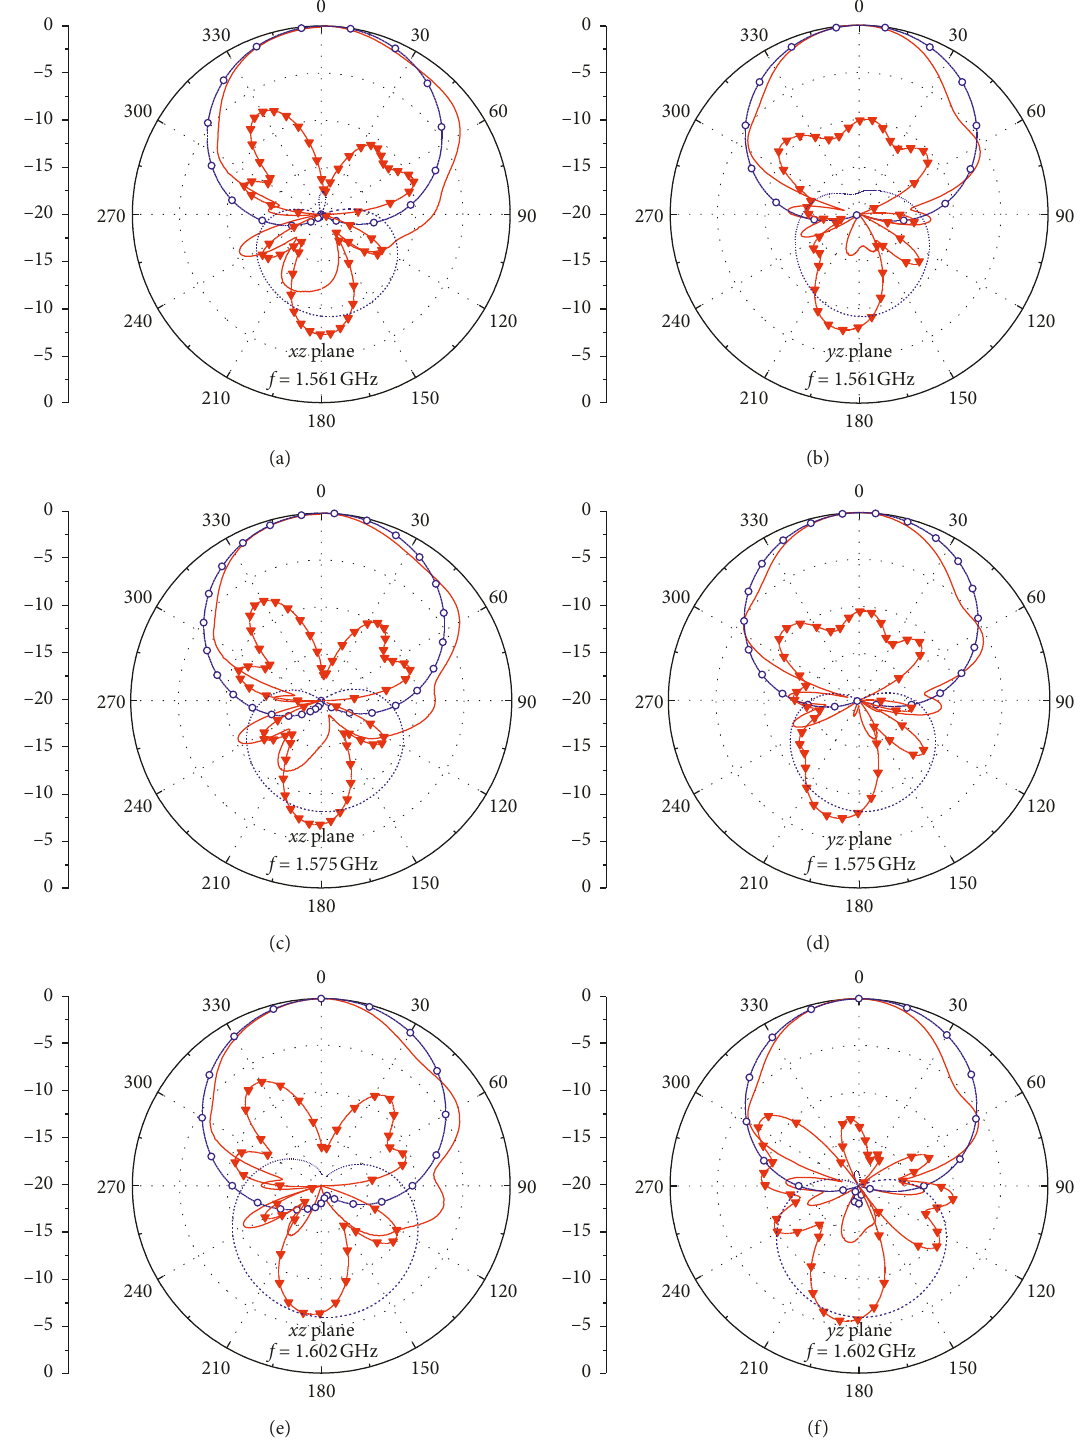
Figure 13: Simulated and measured radiation patterns in the xz plane and the yz plane at (a) f � 1.561GHz, (b) f � 1.575GHz, and (c) f �